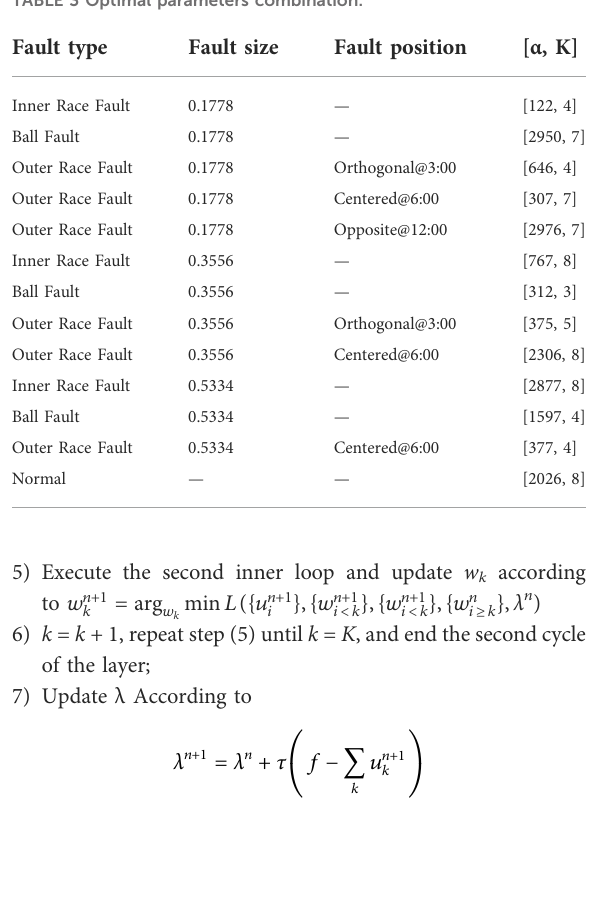
TABLE 3 Optimal parameters combination.